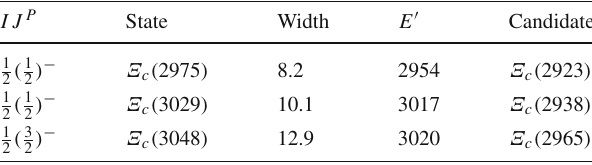
Table 6 The decay width of Ξ 0 c states with mass of 2975 MeV, 3029 MeV and 3048 MeV (unit: